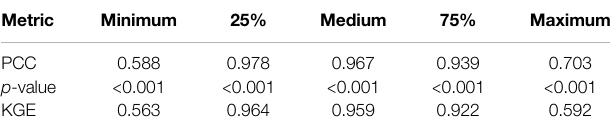
TABLE 3 | Correlation and fi tting of the annual MDP in different percentiles between urban and non-urban regions of the YDM during 1992 –